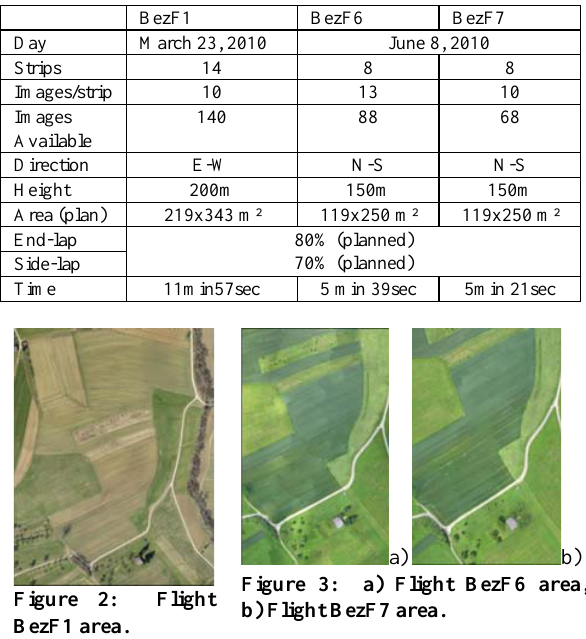
Figure 3: a) Flight BezF6 area, b) Flight BezF7 area.